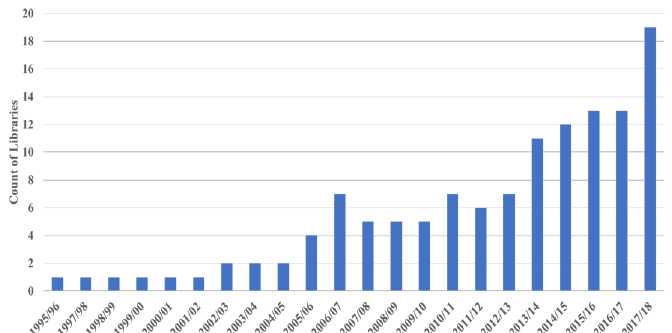
By 2005/06, the percentage spent on digital resources had grown to almost 64% and to almost 92% in 2010/11.